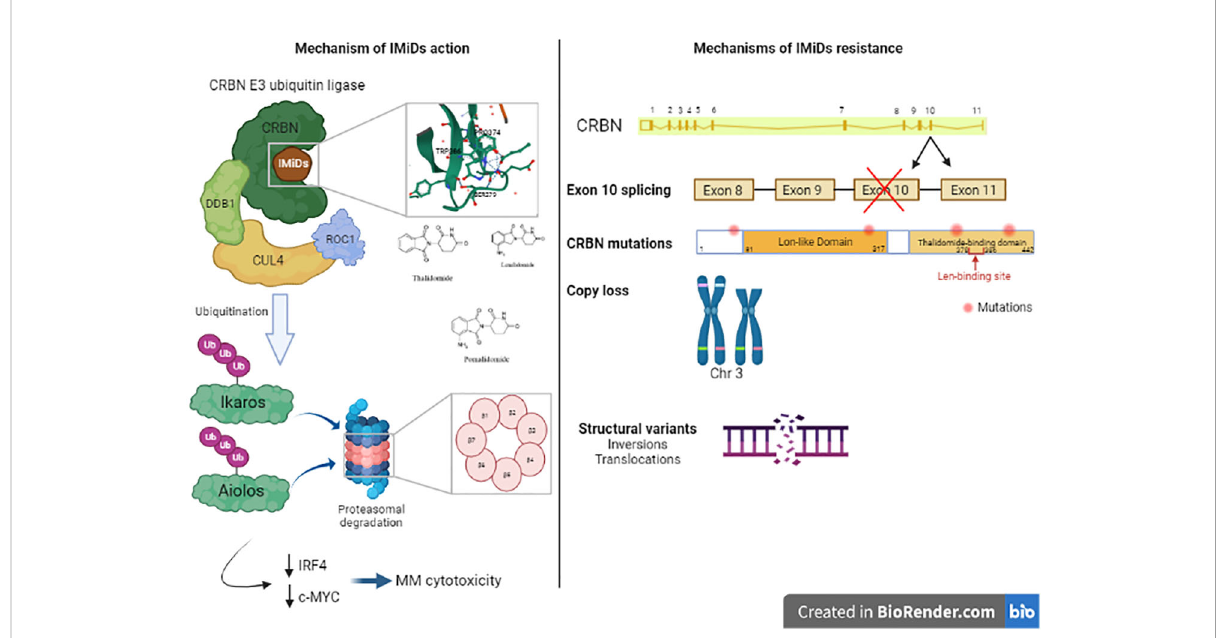
FIGURE 3 Mechanism of action of Immunomodulatory drugs (IMiDs): Immunomodulatroy drugs interacts with Cereblon (CRBN), which is a part of CRBN E3 ubiquitin ligase and induces the ubiquitination of Ikaros and Aiolos and their degradation which decreases the expression of IRF4 and c-MYC, two important factors in MM cell ’ s survival. This leads to MM cytotoxicity. Mechanisms of IMiDs resistance: Acquired resistance to IMiDs is associated with different genetic alterations in CRBN gene including exon 10 splicing, CRBN gene mutations, copy loss or structural variants like inversions or translocations in CRBN locus. These alterations impair CRBN function and consequently, MM cell ’ s response to